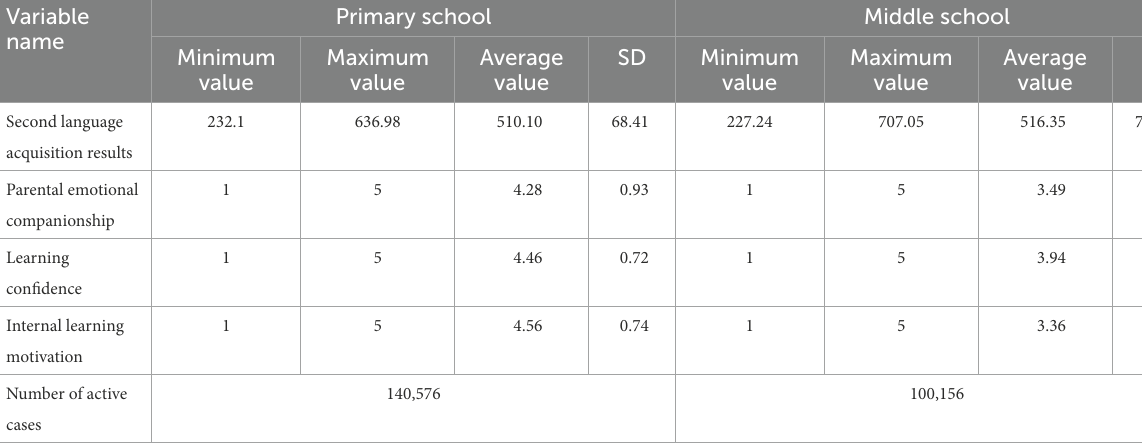
TABLE 1 Descriptive statistics of data.